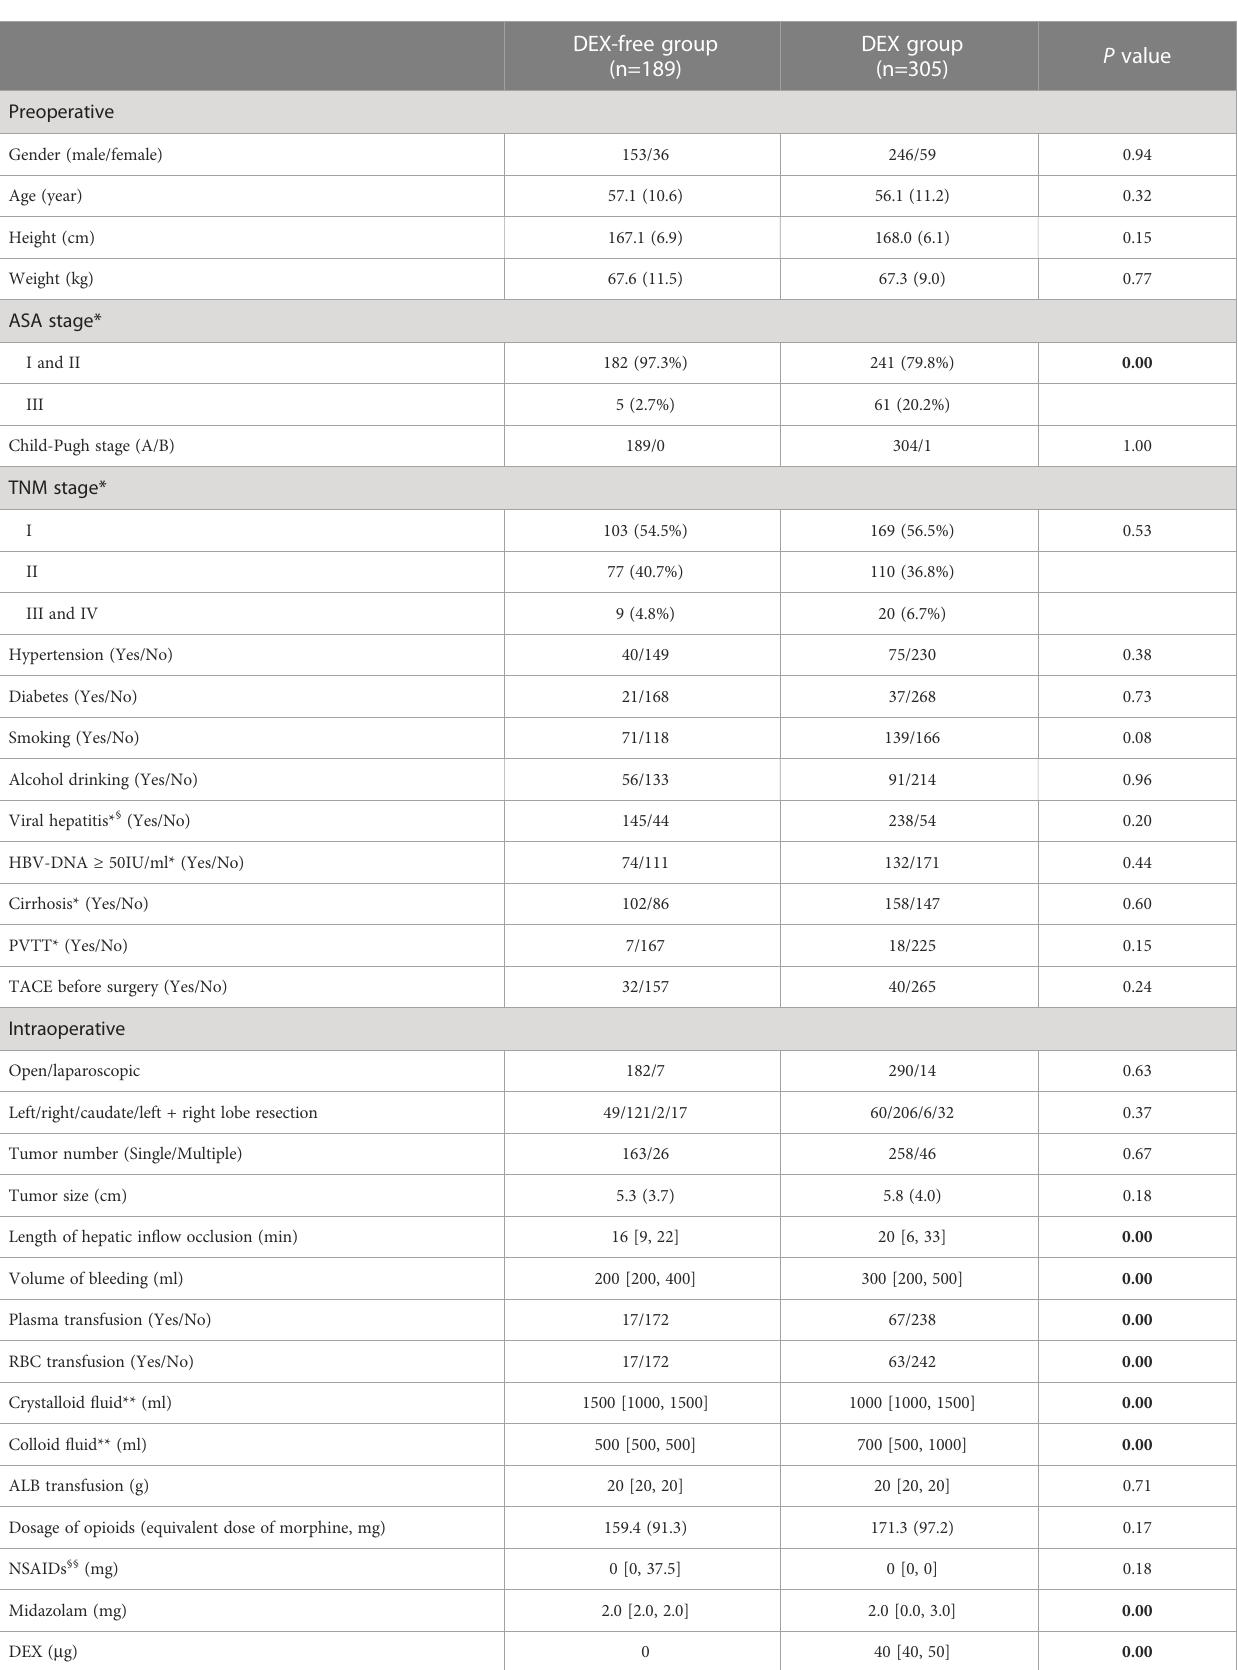
TABLE 1 Clinical characteristics of patients between two groups before